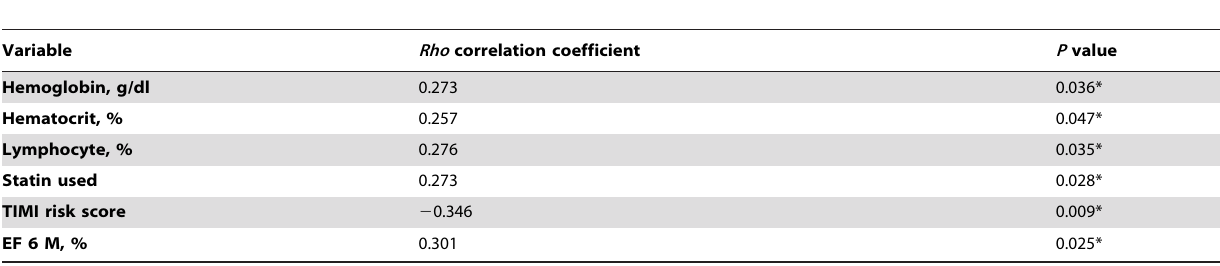
Table 2. Univariate correlation between serum iron concentration and patient characteristics after acute myocardial infarction.